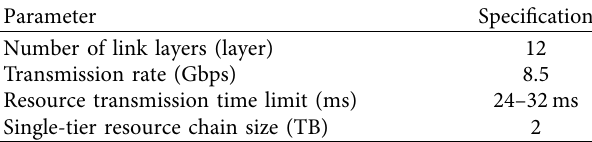
Table 1: Multicast communication layer parameters.